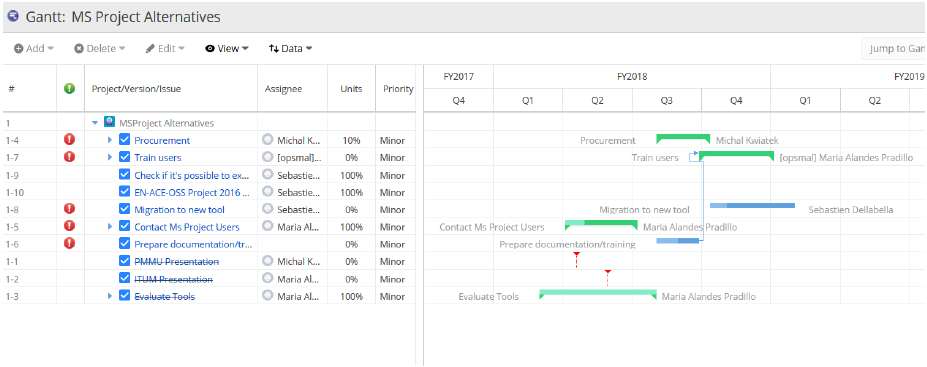
Figure 7. Example of a gantt chart defined with the JIRA WBS Gantt Chart